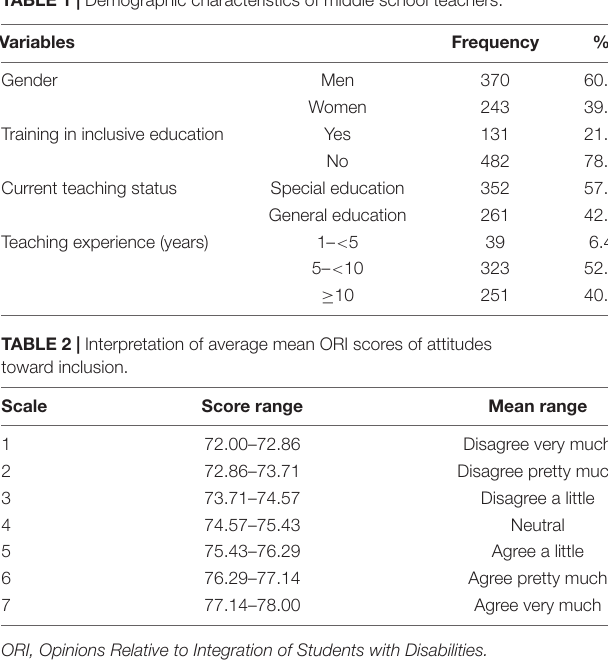
TABLE 1 | Demographic characteristics of middle school teachers.